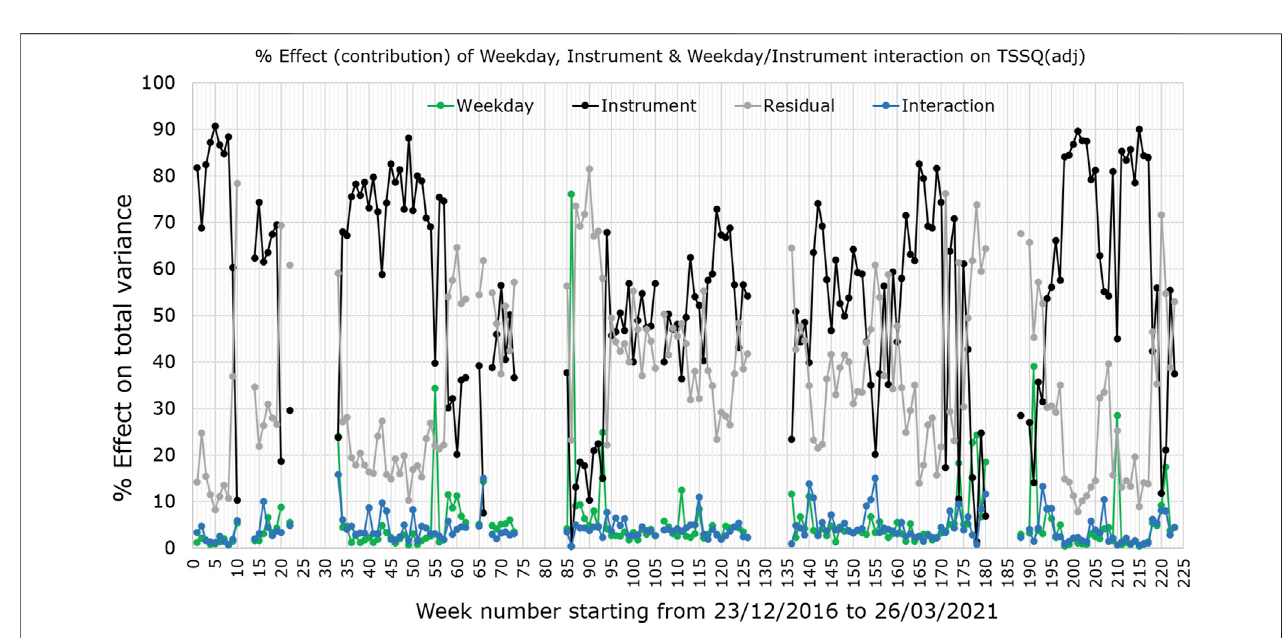
FIGURE 2 | Weekly percentage contribution of instruments (black trace), weekdays (green trace) and weekday/instrument interactions (blue trace), to the total variance (TSSQ, adjusted for sample numbers) in the pilot sample spectra. Also plotted is the residual effect (grey).